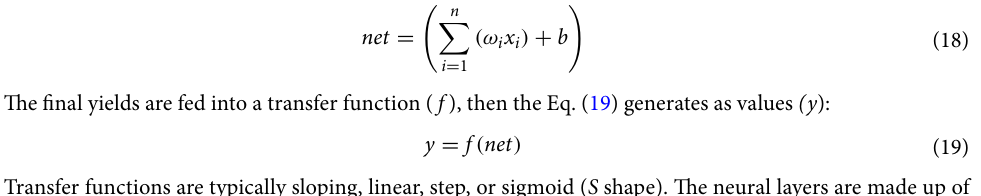
Table 2. Some parameters definitions and their application in the RSM-CCD model. Where, e , y i , and are error value, the measured response data, and the predicted value from the model, respectively. X and H are the model matrix of n rows and p columns. n is the number of runs minus the one being left out and p is the number of terms in the model including the